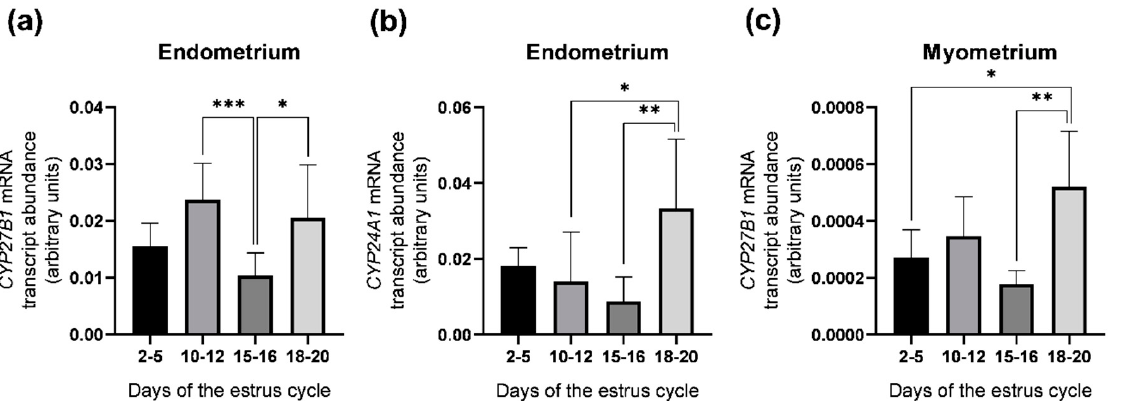
Figure 2. Relative mRNA transcript abundance of CYP27B1 and CYP24A1 in the endometrium ( a , b , respectively) and CYP27B1 in the myometrium ( c ) obtained from pigs on days 2–5, 10–12, 15–16 and 18–20 of the estrous cycle. Relative mRNA transcript abundance (quantitative real–time PCR) was expressed as the ratio relative to GAPDH (glyceraldehyde–3–phosphate dehydrogenase) and was presented as 2 − ∆ Ct . Each value represents the mean ± SD. * p < 0.05; ** p < 0.01; *** p < 0.001 (one–way ANOVA followed by Tukey post hoc test). n = 5 per each group.